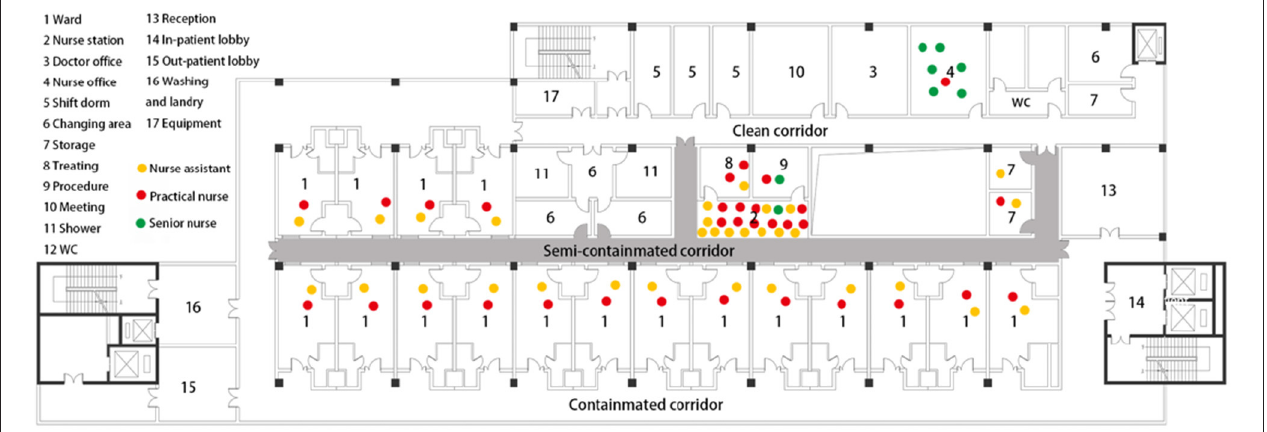
FIGURE 5 | The locations of nurses frequently stay and work.